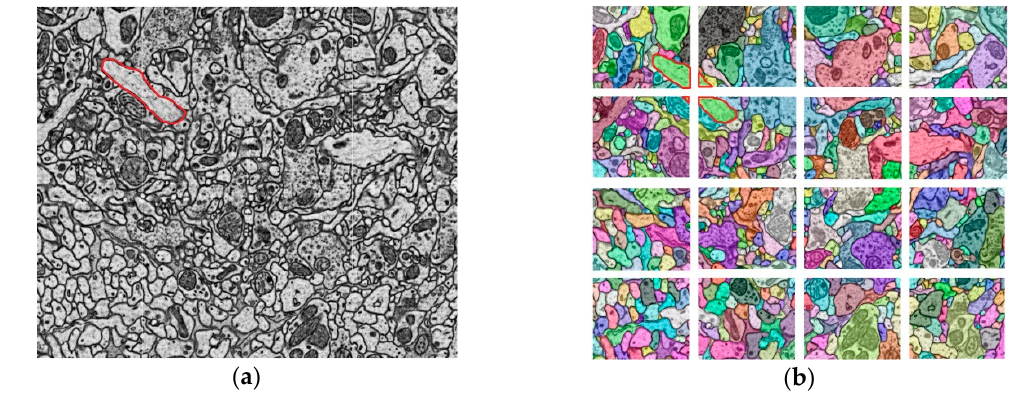
Figure 5. The designed segmentation data model. ( a ) The red line is the contour of the neuron, extracted from segmented data. ( b ) The contour in ( a ) is across four image blocks, so the whole contour data should be stored in each block.